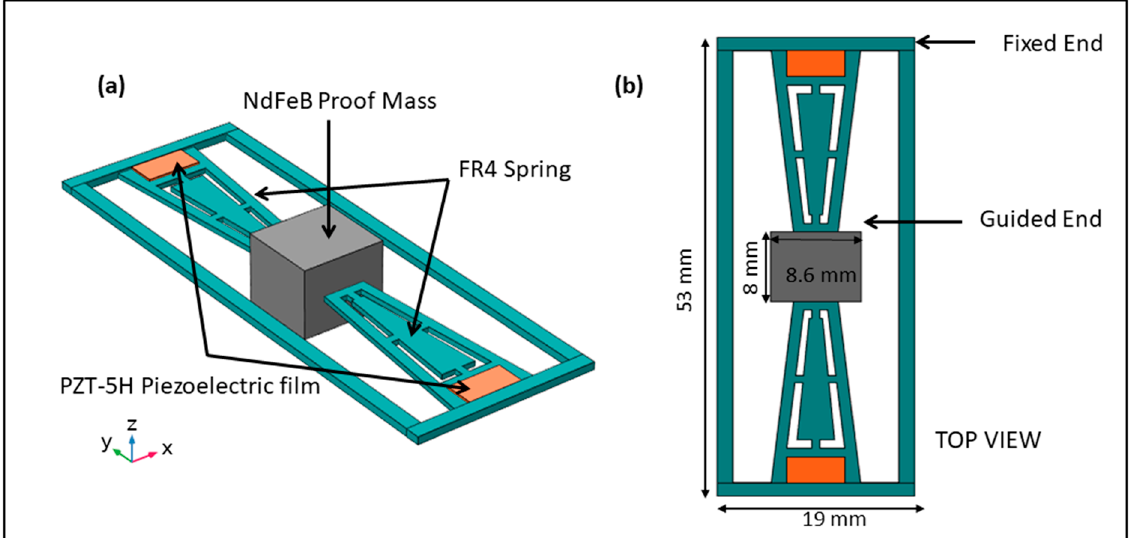
Figure 1. ( a ) Schematic diagram of the proposed nonlinear PEH with an exsect-tapered FR4 spring, and ( b ) top view of the nonlinear PEH.